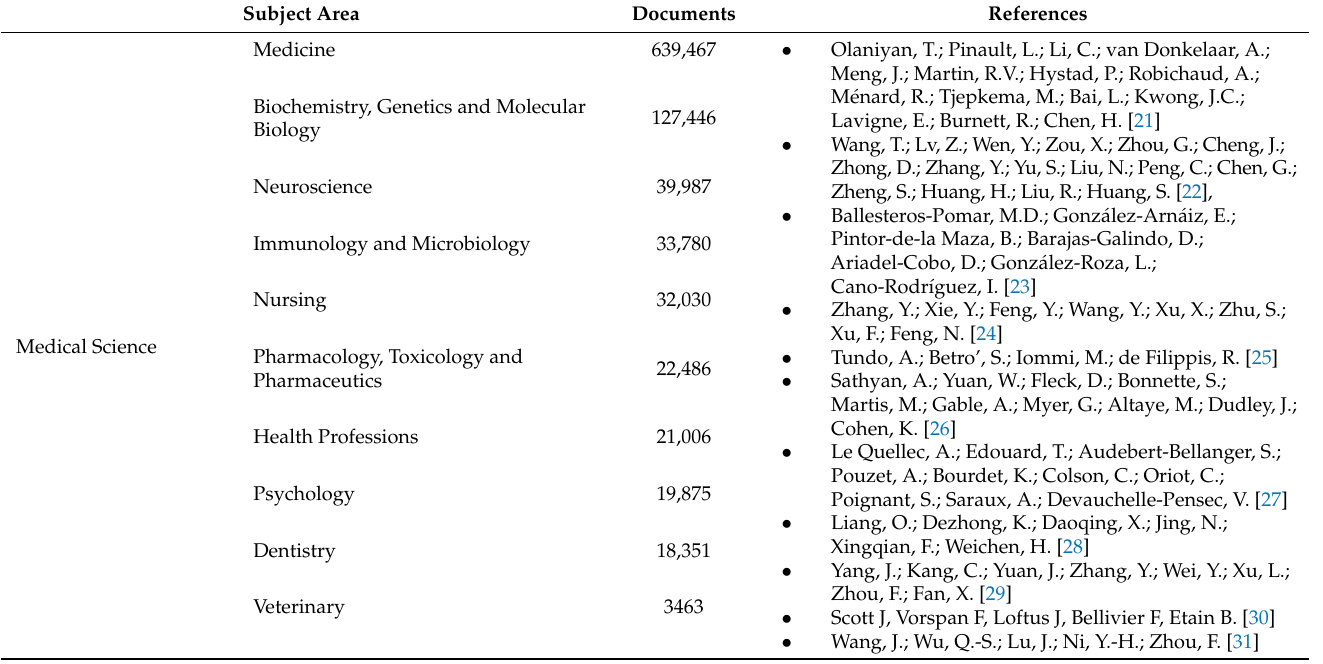
Table 1. Analysis of Cohort analysis keywords usage in Scopus indexed scientific documents.